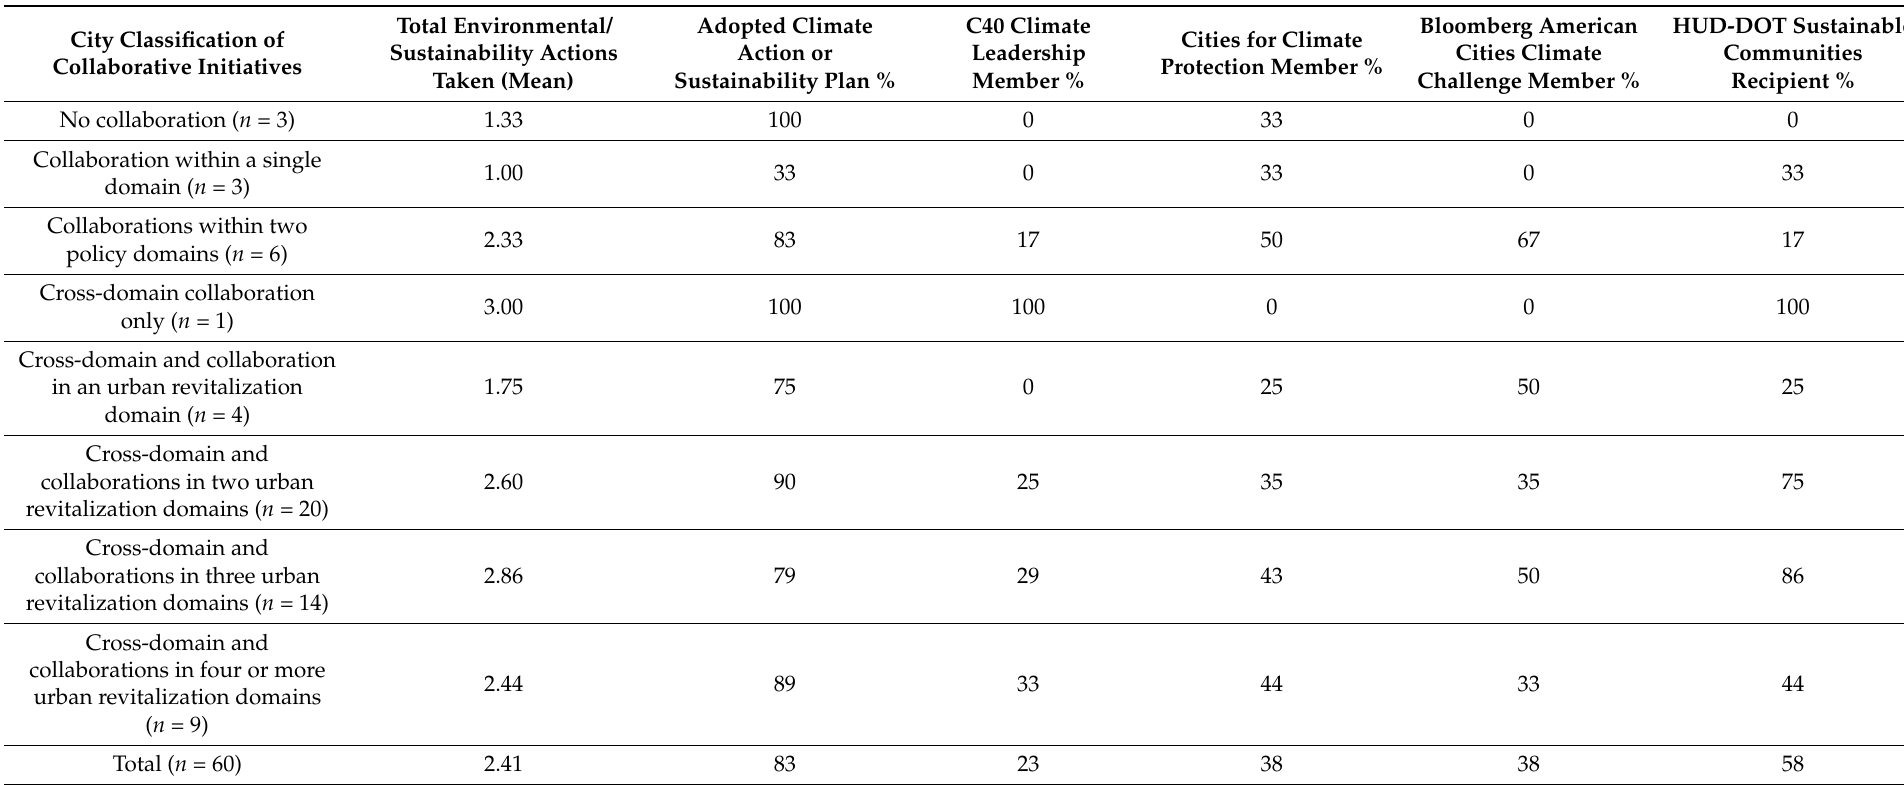
Table 2. City Environmental and Sustainability Actions Taken by Breadth and Depth of City Collaborative Experience. Source: Authors’ coding and calculations. City Classification